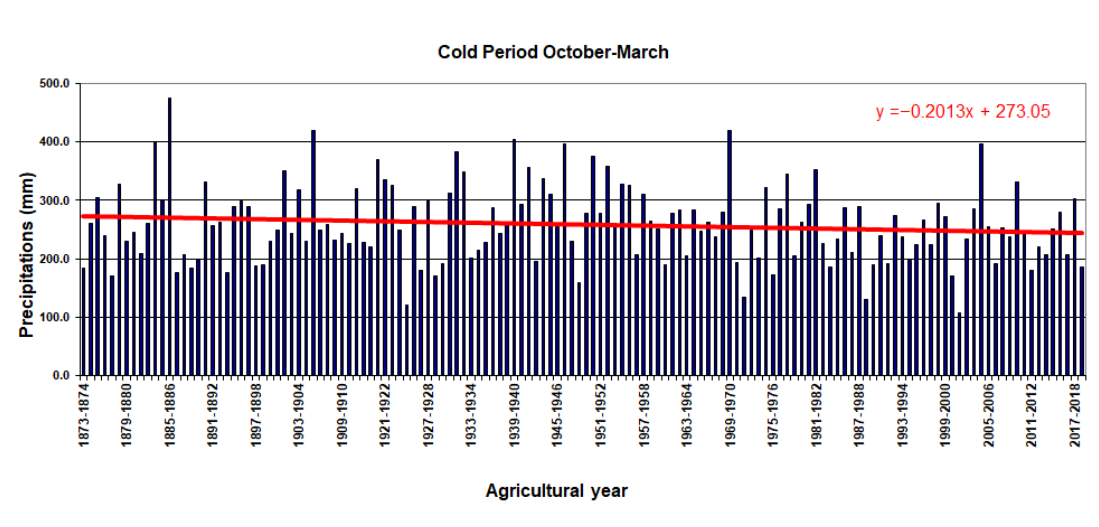
Figure 9. The amount of precipitation fallen in the cold period of the year in the Banat Plain over a period of 146 years period of 146 years (1873 – 2019).